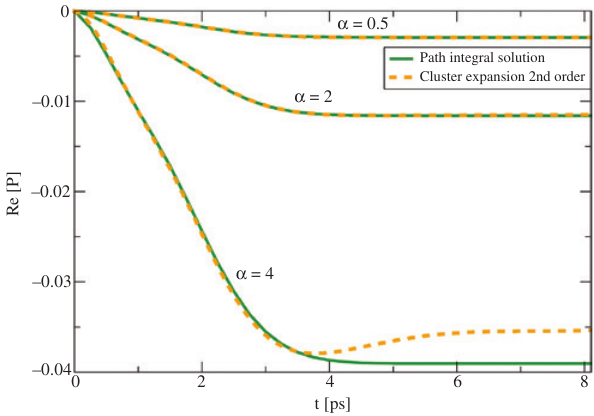
Figure 10: Comparison of the real time path-integral solution with the cluster expansion time-trace for cw excitation.